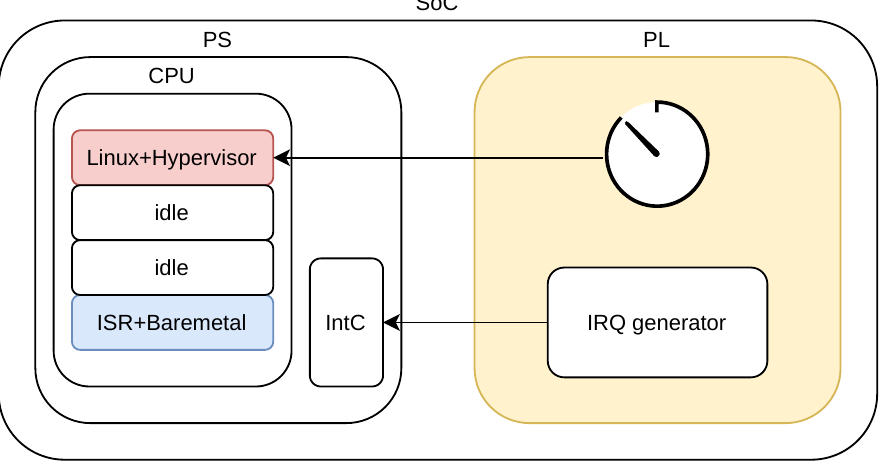
Figure 2. An overall structure of the proposed scenario. There is a hardware periodic interrupt generator, which is paired with a timer. The interrupt sets the timer while the ISR stops